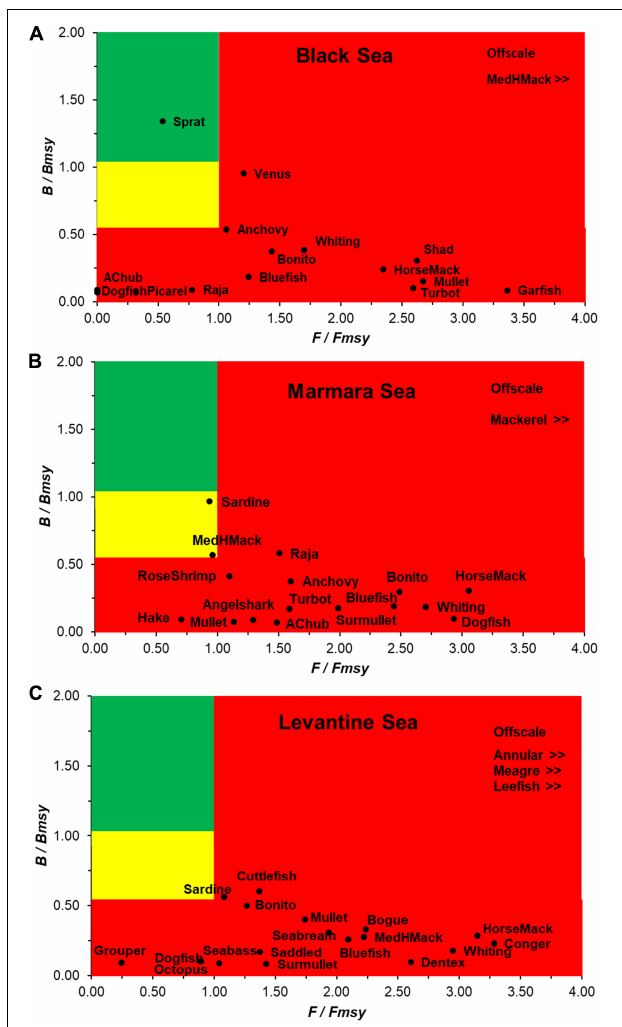
FIGURE 4 | Pressure plots showing fishing mortality (F/Fmsy) and relative stock size (B/Bmsy) for the assessed stocks in the (A) Black Sea, (B) Marmara Sea, and (C) Levantine Sea for 2017. The red area indicates overfished stocks (including those outside of safe biological limits, in critical condition, and severely depleted). The yellow area indicates recovering stocks and the green area shows healthy stocks. Scientific names of the fish were presented in Table 1